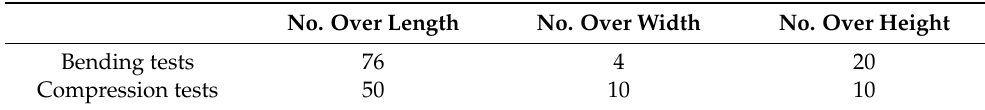
Table 2. Number of elements of the FE mesh of the bending and the compression tests in the respective